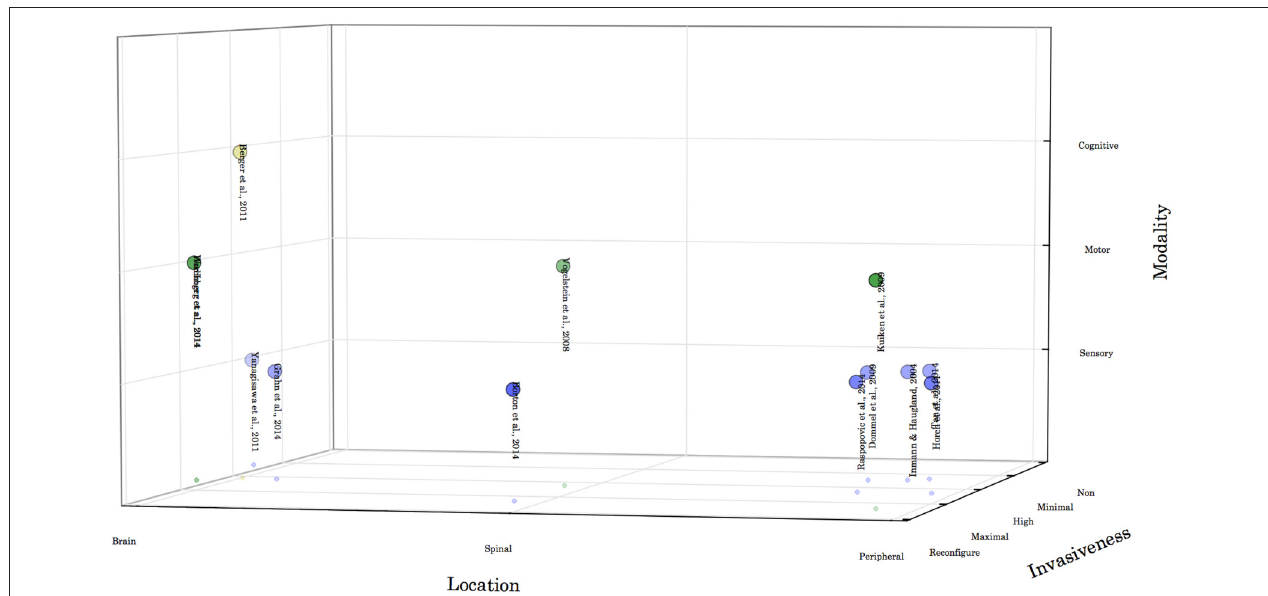
FIGURE 1 | Neuroprosthetic Systems. An illustration of the conceptual space of neuroprosthetic devices. Devices can be classified as similar if they provide assistance in the same Modality, have an equivalent level of Invasiveness, or interface with the user’s nervous system in the same